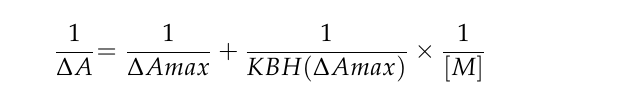
Figure 2. UV ‐ Visible titration Studies: ( a ) Variation of Chymo with constant AzC; ( b ) Variation of AzC with constant Chymo; ( c ) Variation of AzC ‐ ZnONPs with constant Chymo ( d ) Variation of Chymo with constant AzC ‐ ZnONPs.